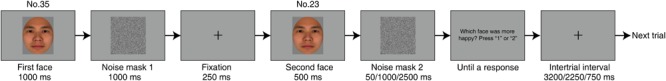
The trial procedure of Experiment 3. In each trial, the first facial expression was presented for 1000 ms, followed by a 1000 ms noise mask 1. After a 250 ms fixation cross, the second facial expression was presented for 500 ms, followed by a 50 ms, a 1000 ms, or a 2500 ms noise mask 2. These three various durations were counterbalanced across sessions. Then the question “which facial expression was happier” appeared until participants made a response by pressing “1” or “2.” The next trial started after a 3200 ms, a 2250 ms, or a 750 ms intertrial interval, depending on the corresponding delay durations of noise mask 2.